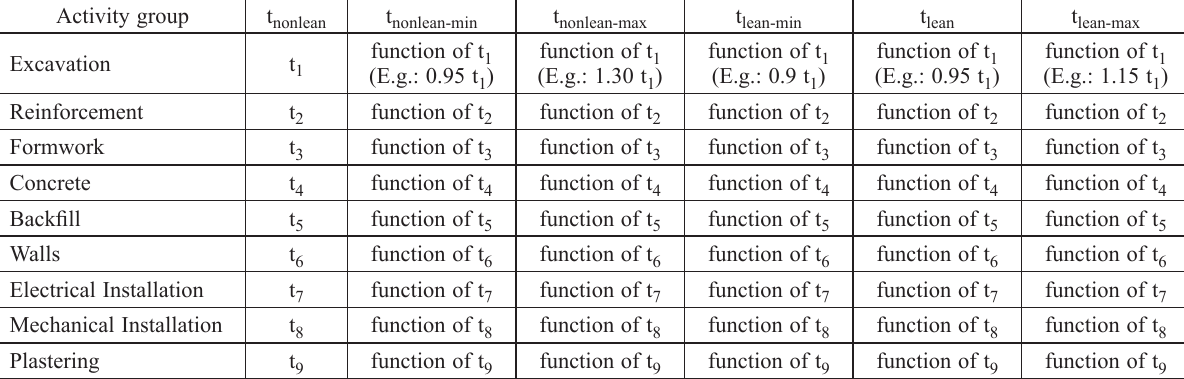
Table 3. Identification of the activity durations for both scenarios Activity